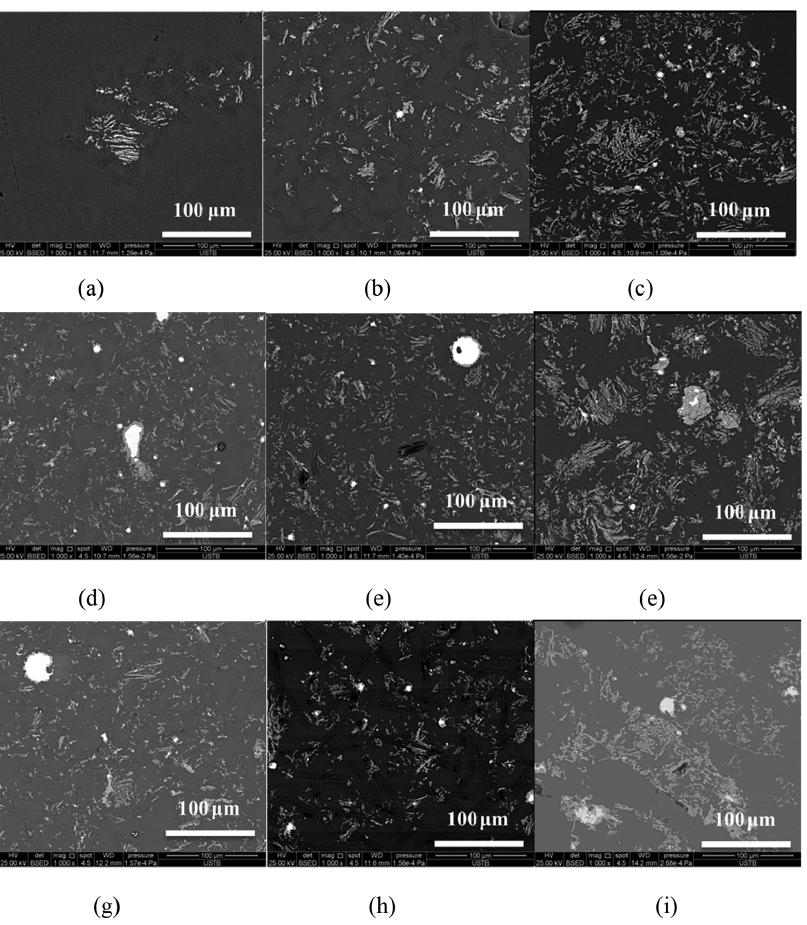
Figure 18: BSED images of the samples reduced with different carbon ratios for different times at 1,773 K: (a) 2 h, 0.7; (b) 2 h, 0.85; (c) 2 h, 1.0; (d) 4 h, 0.7; (e) 4 h, 0.85; (f) 4 h, 1.0; (g) 6 h, 0.7; (h) 6 h, 0.85 and (i) 6 h,